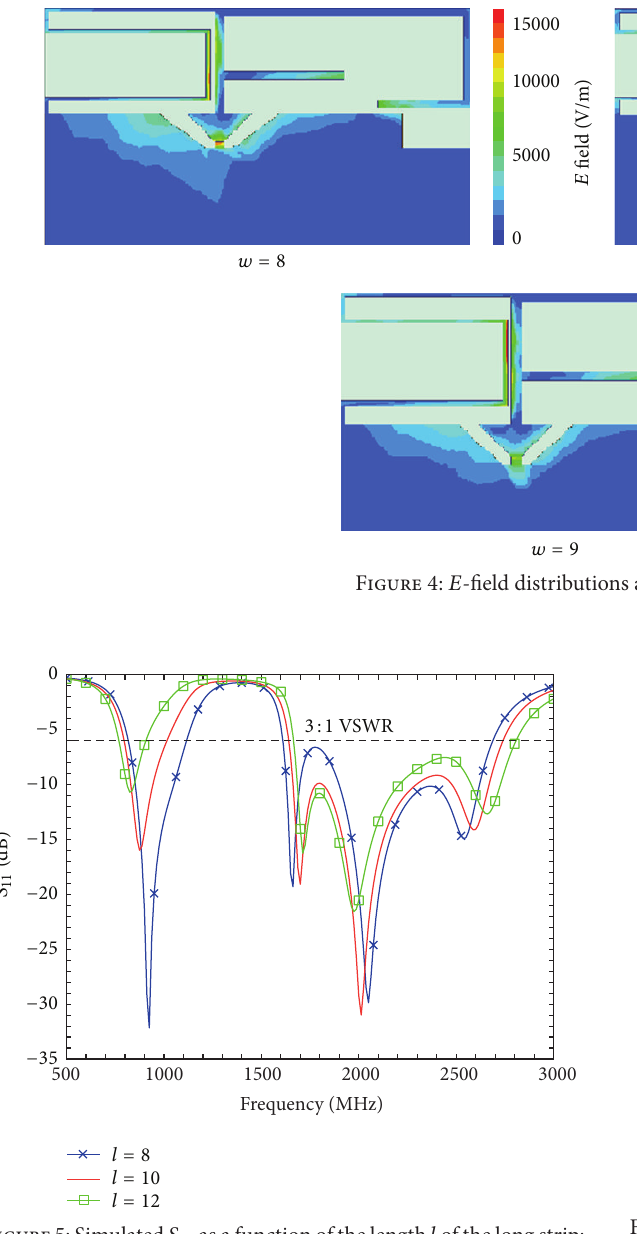
Figure 5: Simulated 𝑆 11 as a function of the length 𝑙 of the long strip; other dimensions are the same as given in Figure 1 (unit: mm).